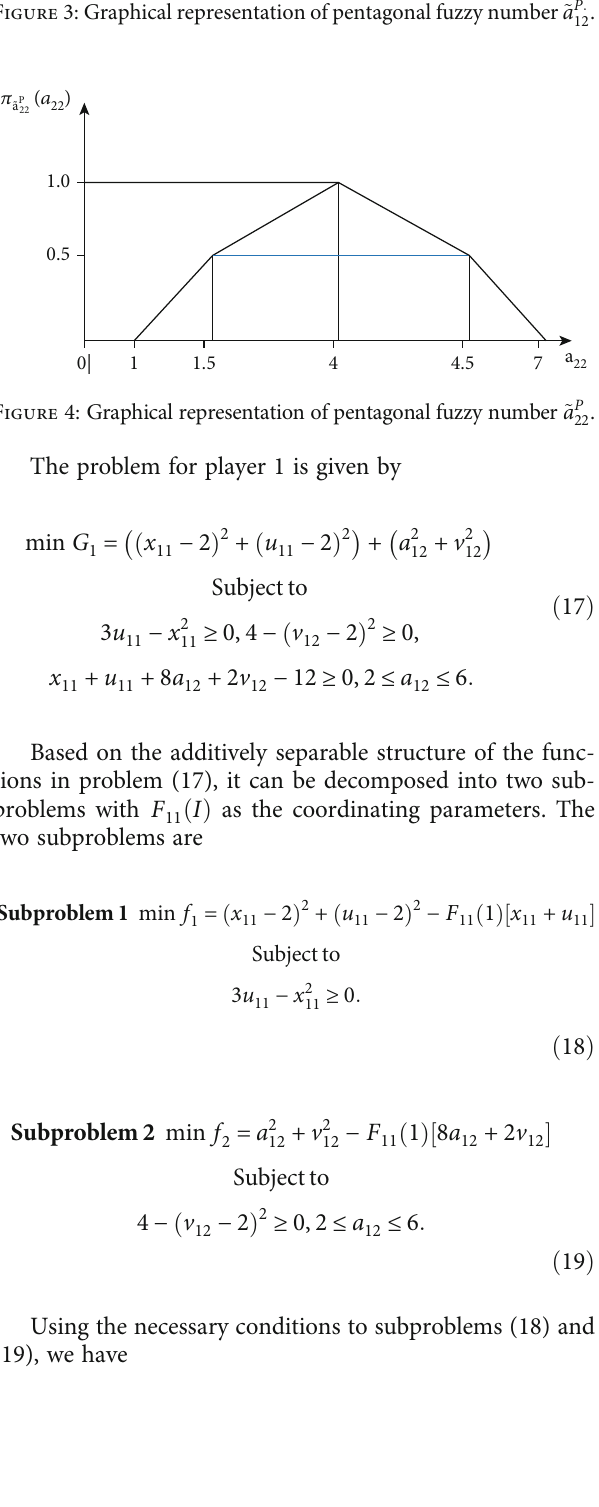
Figure 3: Graphical representation of pentagonal fuzzy number ~ a P :